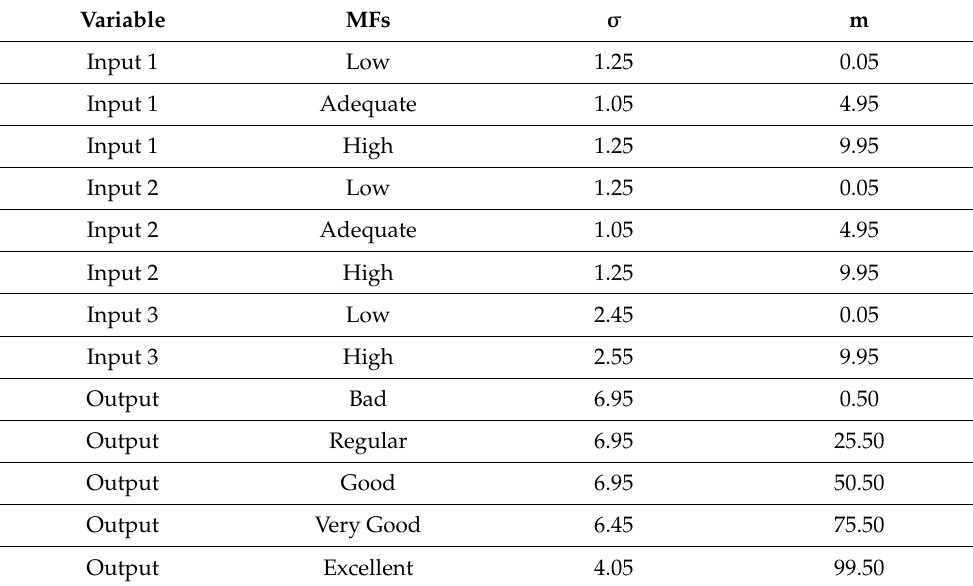
Table 2. Parameterization that was utilized in the NMFs.